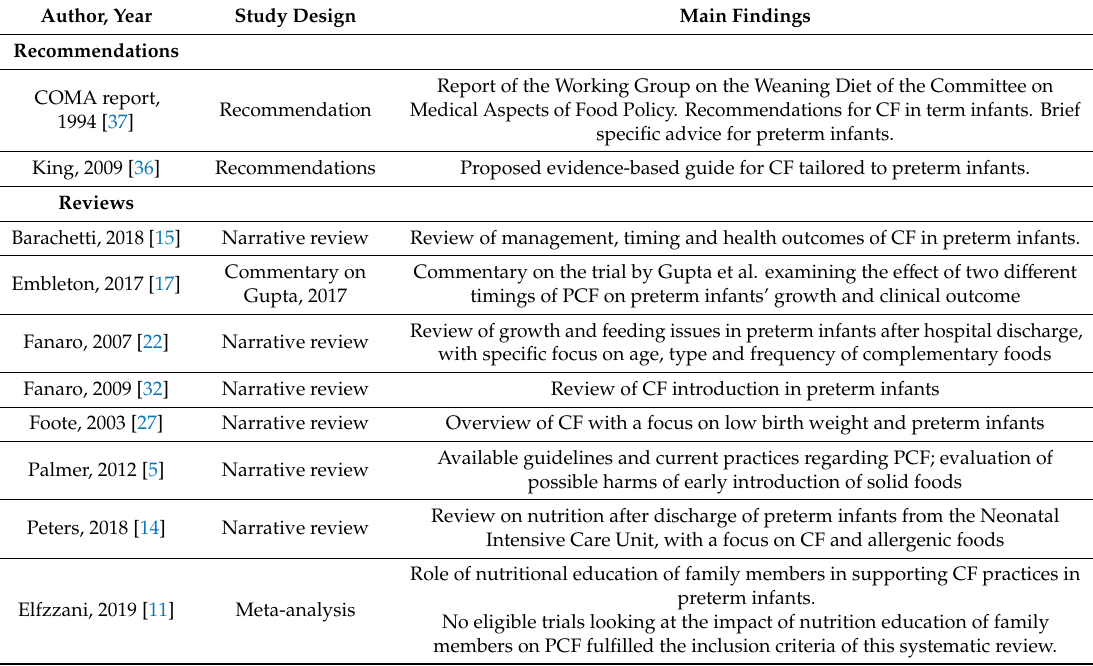
Table 1. Main characteristics of the studies included in the systematic review are described. Studies are classified according to study design: recommendations, reviews, and trials. CA: corrected age; CF: complementary feeding; PCF: preterm complementary feeding; RCT: randomized controlled